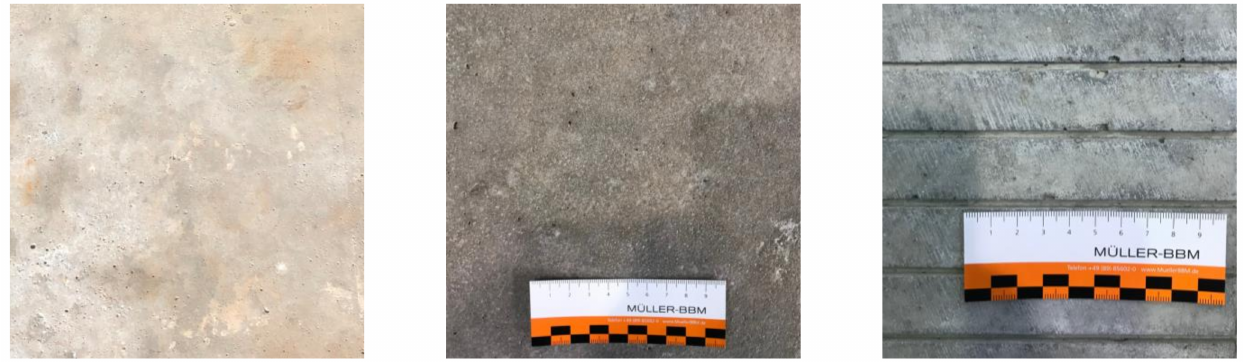
Figure 2. Detailed surface images of SHCC ( left ), modified SHCC-Cor ( center ), and SHCC-Cor- Gro ( right ).